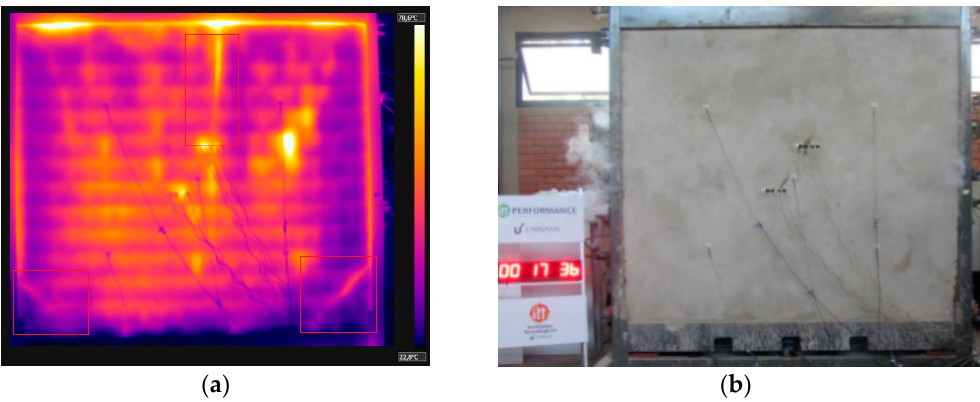
Figure 13. ( a ) Vertical and oblique cracks; ( b ) Smoke coming out of the vertical crack and its surroundings.